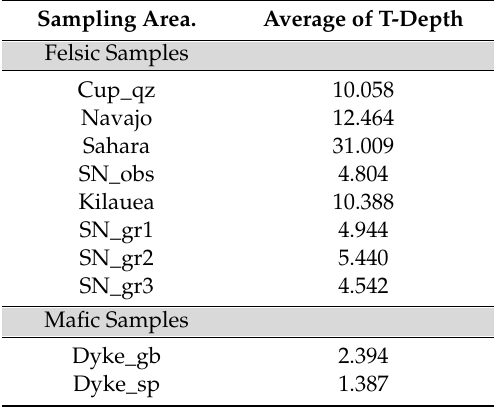
Table 3. Average T-depth values in each sampling area.